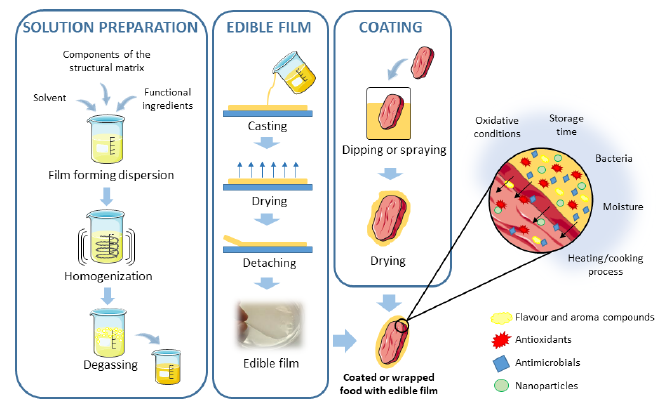
Figure 2. Scheme for the preparation of edible films and coatings and the different bioactive compounds that can be incorporated into them. Adapted from References [31,73]. Polysaccharides used in these applications can be classified depending on their origin: Animal- derived compounds (e.g., chitin and chitosan), plant-derived (e.g., cellulose, starch, pectin, and gum Arabic), seaweed-derived (e.g., agar, alginate, and carrageenan), and microbial-derived (e.g., pullulan, gellan, and xanthan gum). Lipid compounds, such as oil, resins, or waxes, have also been used, and protein-based films (e.g., gelatin, collagen, milk, soy, and whey proteins) are also being studied [71]. All these compounds are supposed to be non-toxic and used as the inner layers that are directly in touch with the food products [75,76]. Table 2 lists some examples of applications of edible films and coatings based on different edible materials. Current studies have also been focused on composite films and coatings based on a multicomponent approach to take advantage of the best properties of each component, avoiding their individual drawbacks and enhancing the properties of the food [76]. All of these compounds have potential as natural preservatives and as molecules’ carriers for the enhancement of food quality. Table 2. Examples of food applications of edible films and coatings based on different edible materials. Coating Material